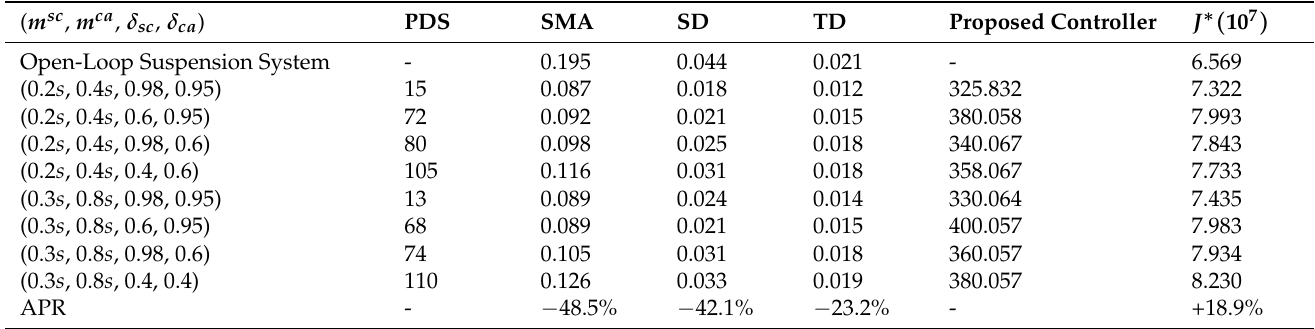
Table 2. RMS values of performance indicators under road roughness with G d ( Ω 0 ) = 64 × 10 − 6 m 3 .